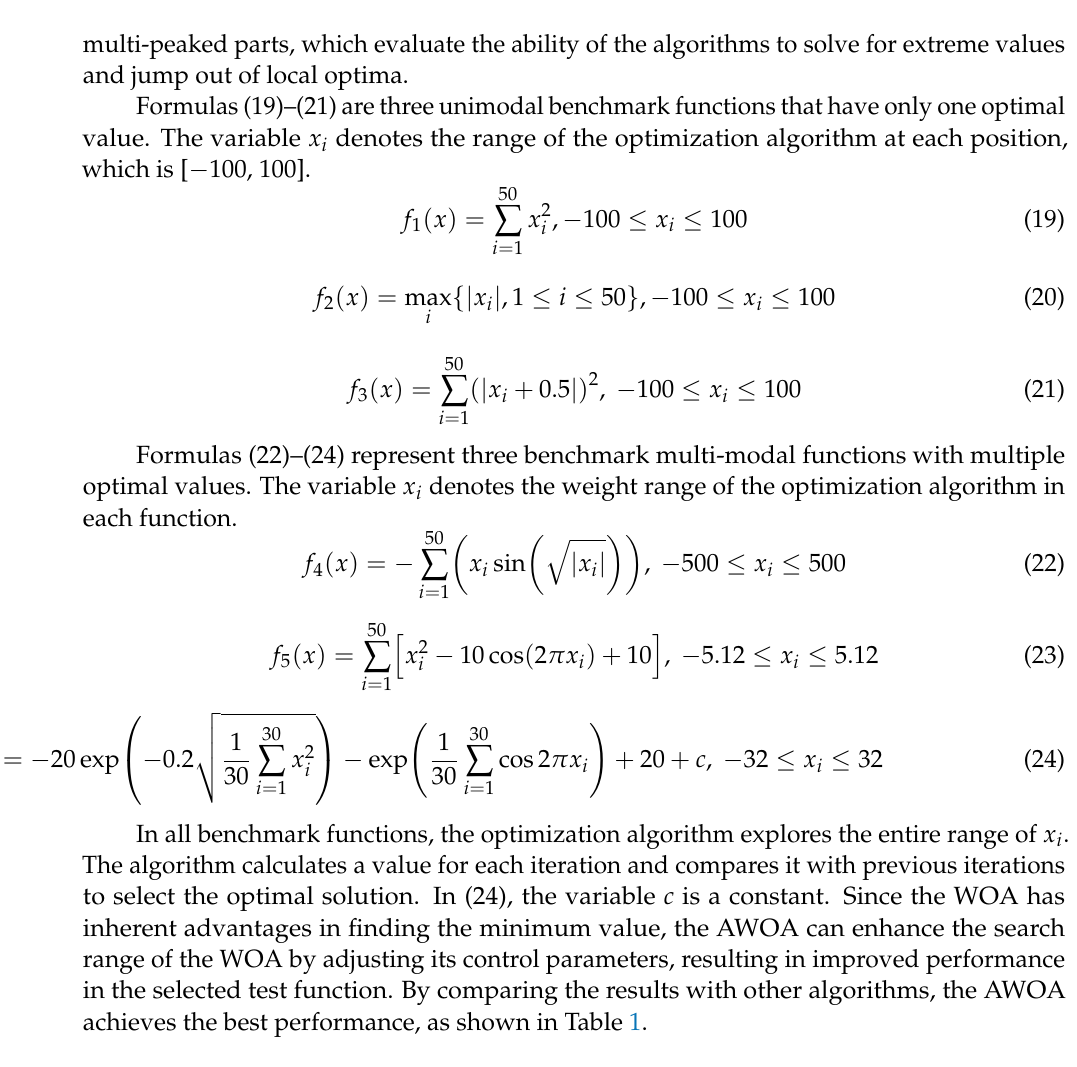
Table 1. Results comparing four kinds of algorithms.